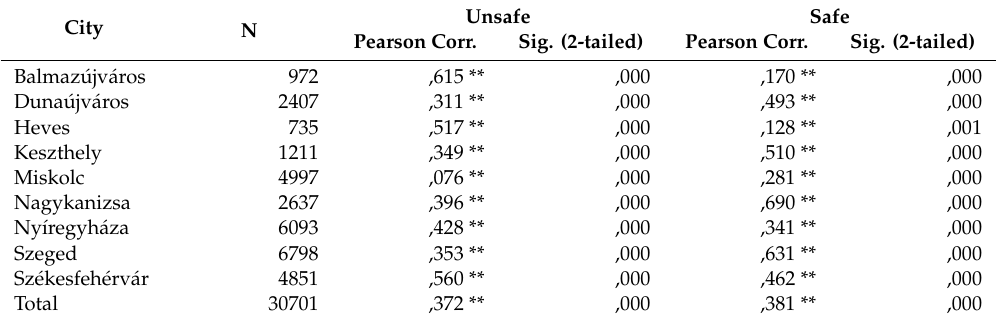
Table 1. Grid level correlation between the number of registered crime events and the normalized number of marking a location unsafe or safe in the observed cities. Unsafe Safe City N Pearson Corr. Sig. (2-tailed) Pearson